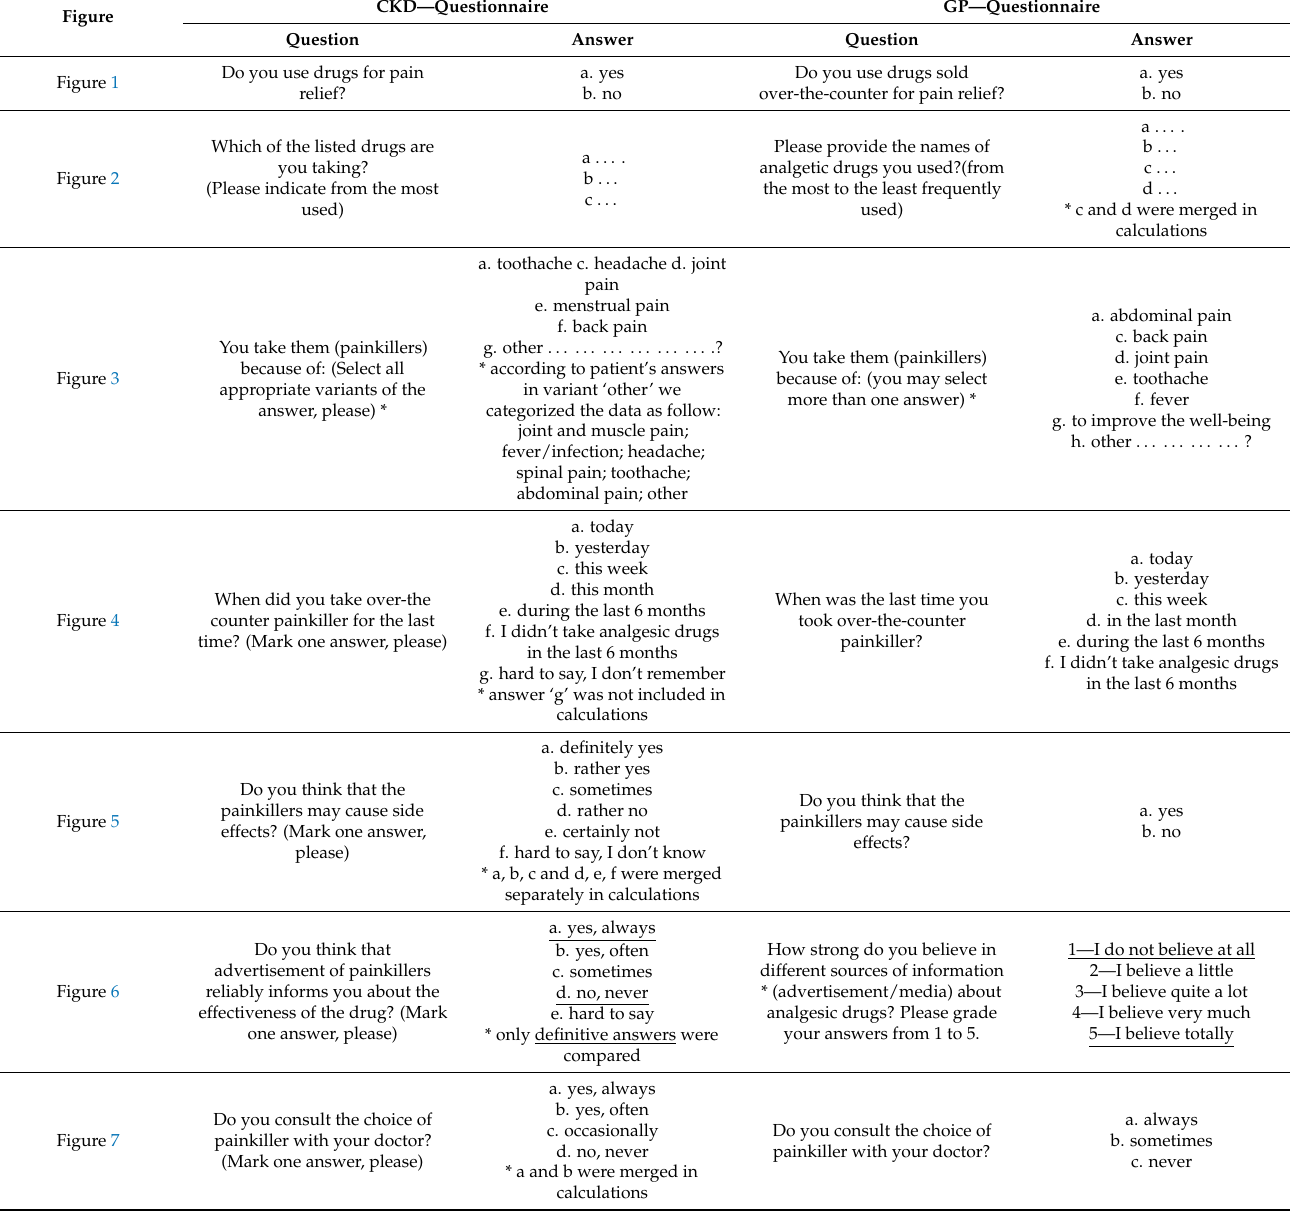
Do you consult the choice of painkiller with your